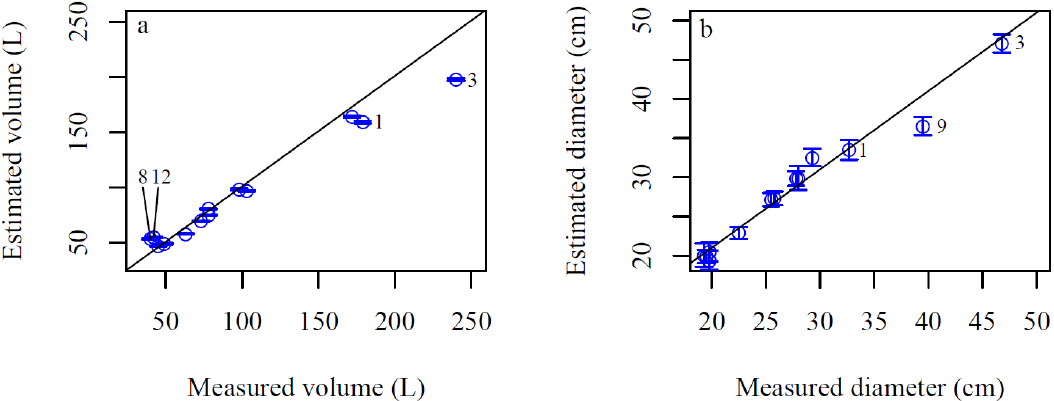
Figure 7. ( a ) Measured and estimated root system volume and ( b ) stump diameter. Vertical bars are the standard deviations for the predicted values for 15 model fits for each root